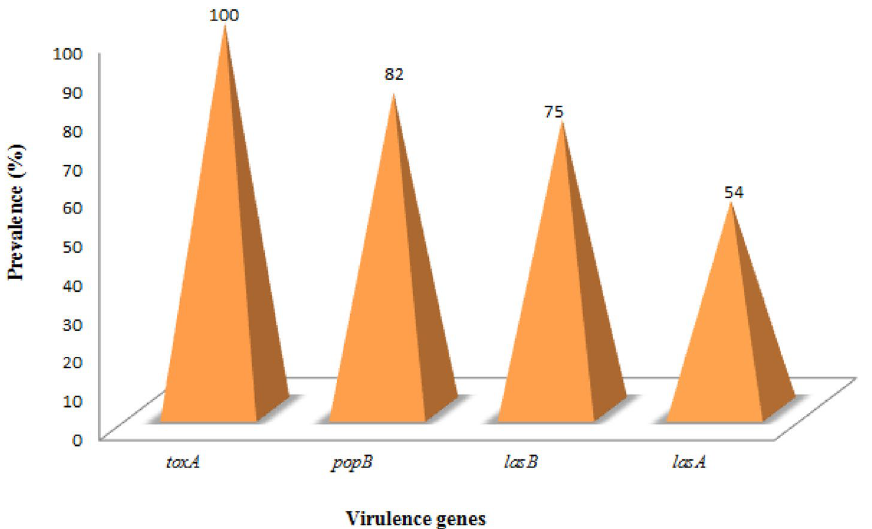
Figure 7. Prevalence of virulence genes among all confirmed P. aeruginosa